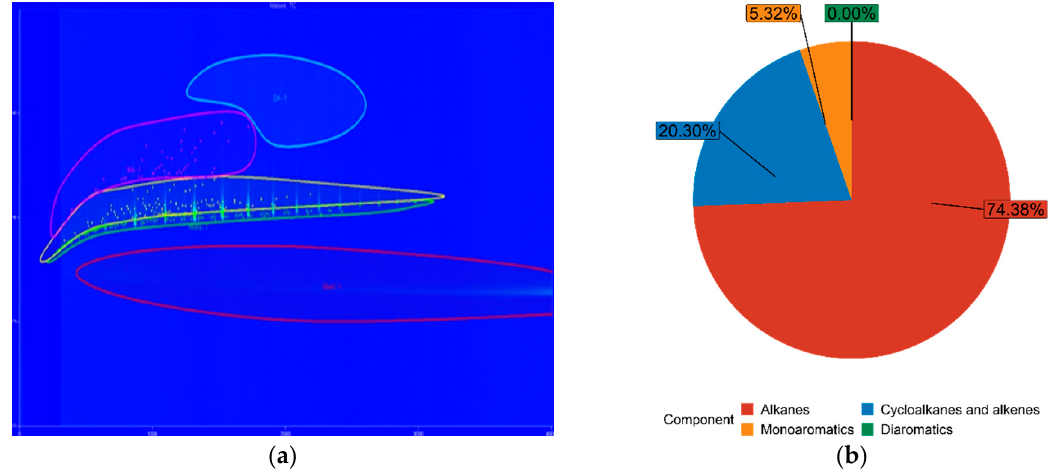
Figure 13. ( a ) Output of GC × GC-TOFMS for 15% FT − diesel; ( b ) hydrocarbon composition of 15% FT − diesel.